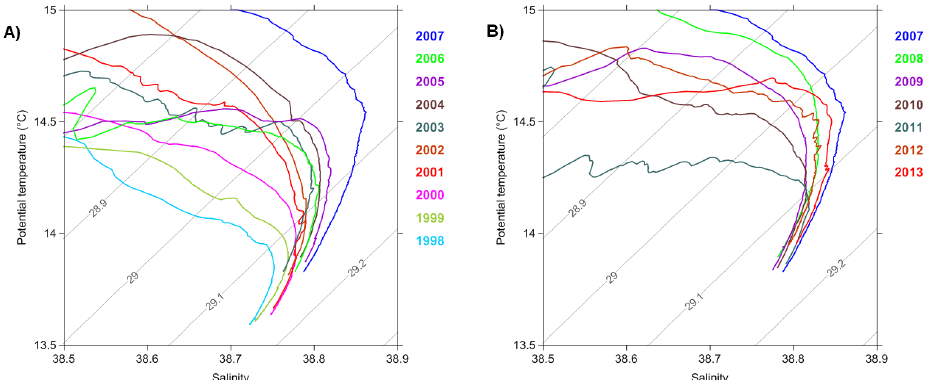
Figure 8. 2 - S diagrams of the intermediate layer in the Strait of Sicily (Station 945): (a) period 1998–2007 and (b) period